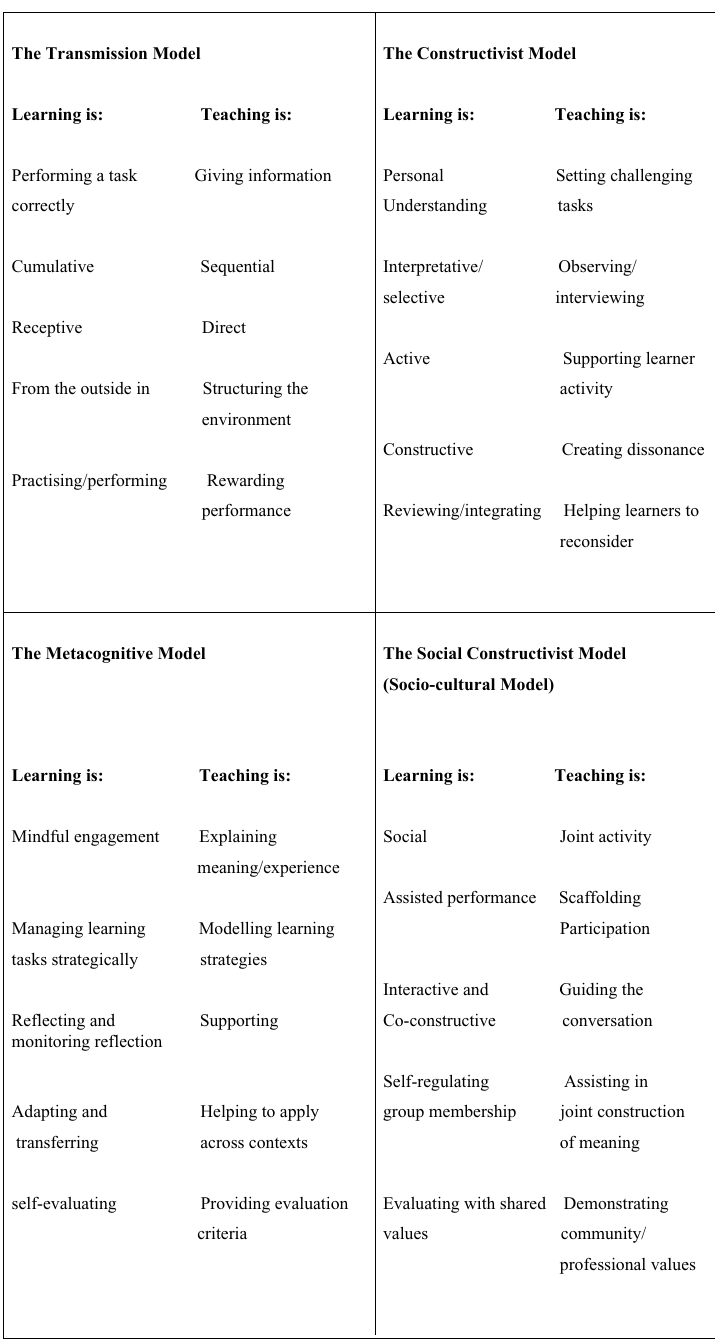
Figure 3. Contrasting approaches to learning and teaching (adapted from Renshaw,